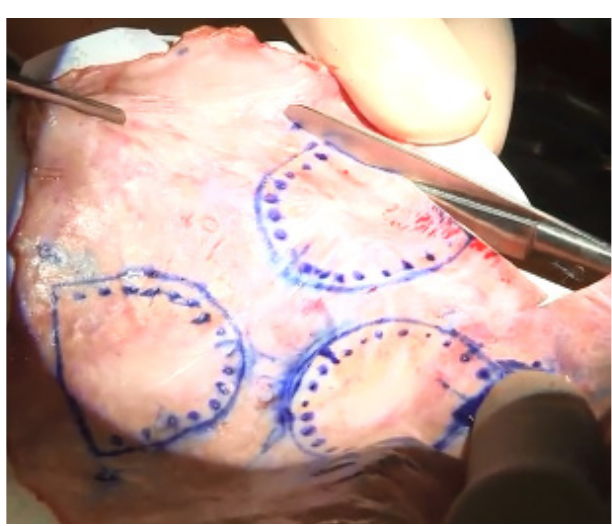
Fig. 2 – Trimming of treated autologous pericardium with the corresponding measured value using template.